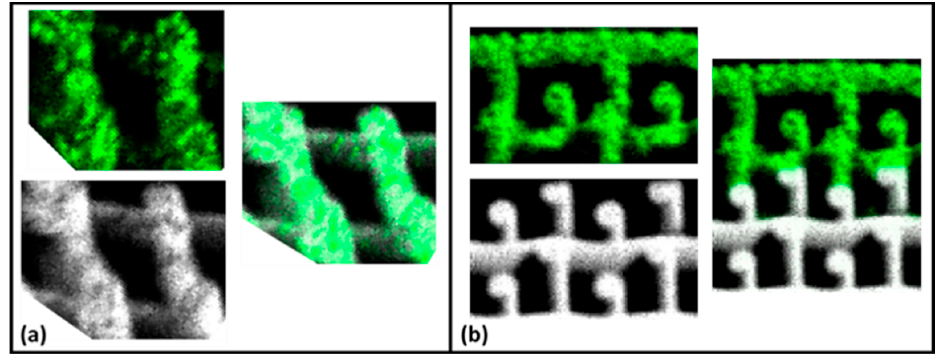
Figure 11. 3D printing with formulations of WO 3 and Gd 2 O 3 ( a ) in one ink to create a homogeneous part and ( b ) as separate inks to produce a heterogeneous part.